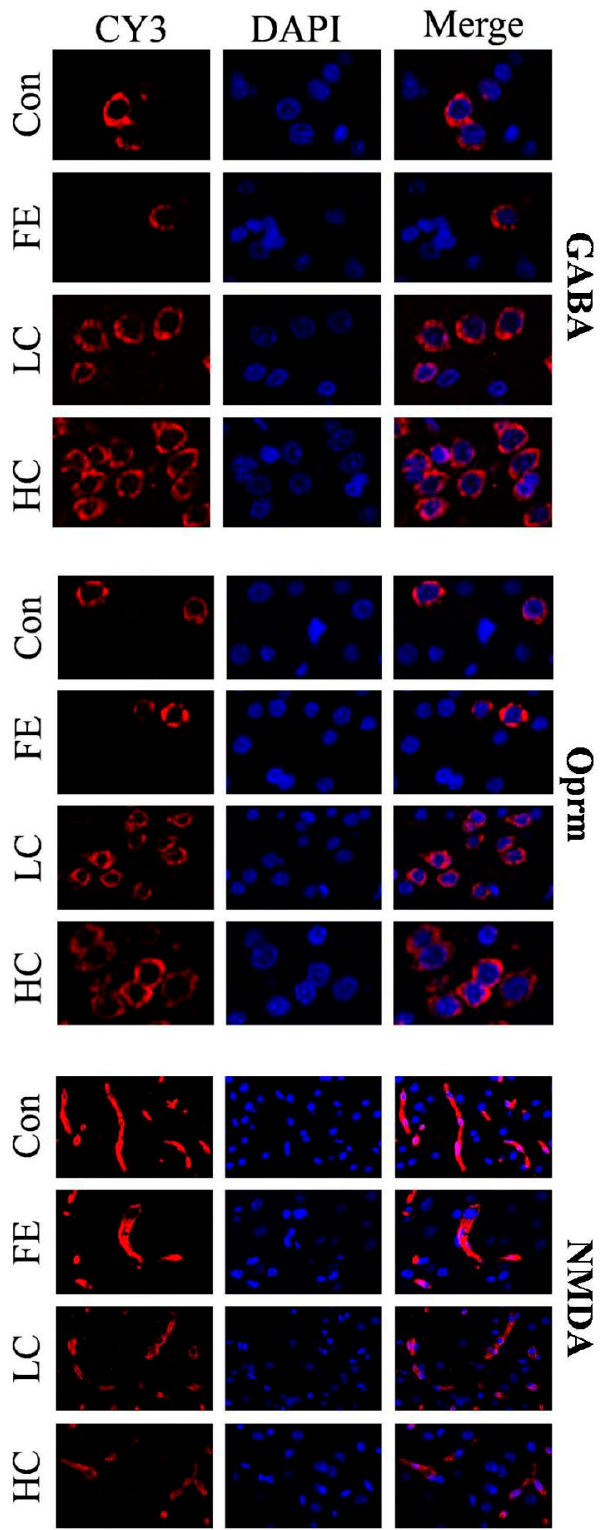
Figure 3. After treatments with different treatment groups, the expression levels and localization of the target protein in the parietal tissue of the cerebral cortex of SD rats. CY3 fluorescence detected gamma-aminobutyric acid A receptor 1 (GABA A 1), N-methyl-D-aspartate receptor subunit 1 (NMDAR1), and µ -opioid receptor 1 (OPRM1) (red), and DAPI detected cell nuclei (blue). These data represent three independent experiments.